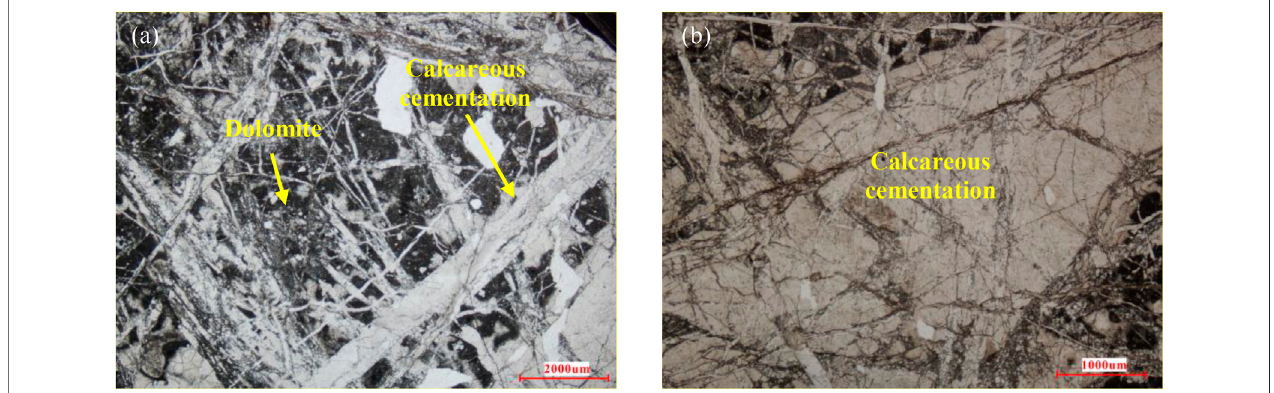
FIGURE 13 | Carbonate fault materials with low-strength cementation from microscope. 2 × 10 (A) , 4 × 10 (B) .